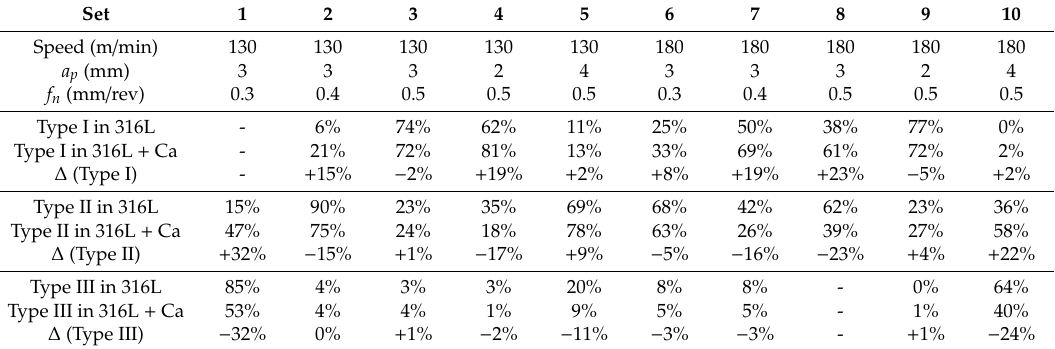
Table 4. Summary of results based on weighting measurements and calculated I Wchip